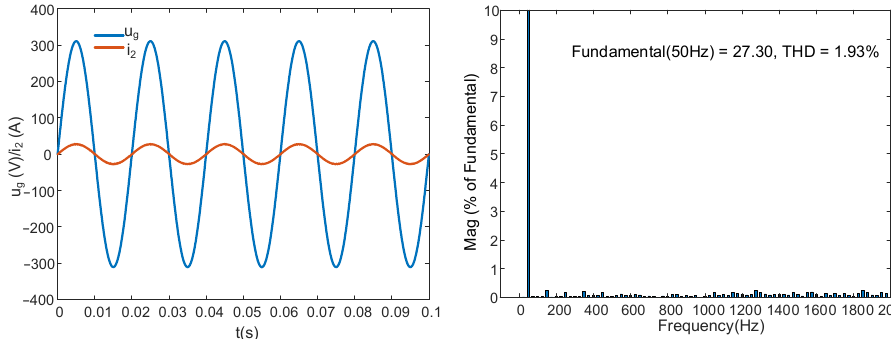
Figure 12. Simulation results of the “IOGCI + IOPI” system.